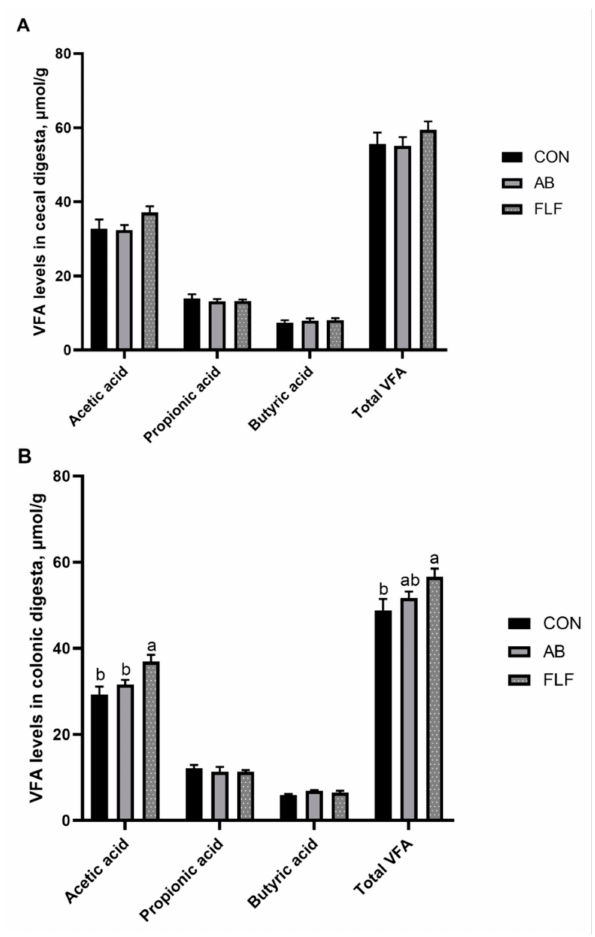
Figure 3. Effects of fermented liquid feeding on the levels of volatile fatty acids in the cecal ( A ) and colonic ( B ) digesta of pigs ( µ mol/g) Values are means ± SEM, ( n = 6). CON: control group; AB: antibiotics group; FLF: fermented liquid feeding group. a, b mean values with different letters on vertical bars indicate significant differences ( P <